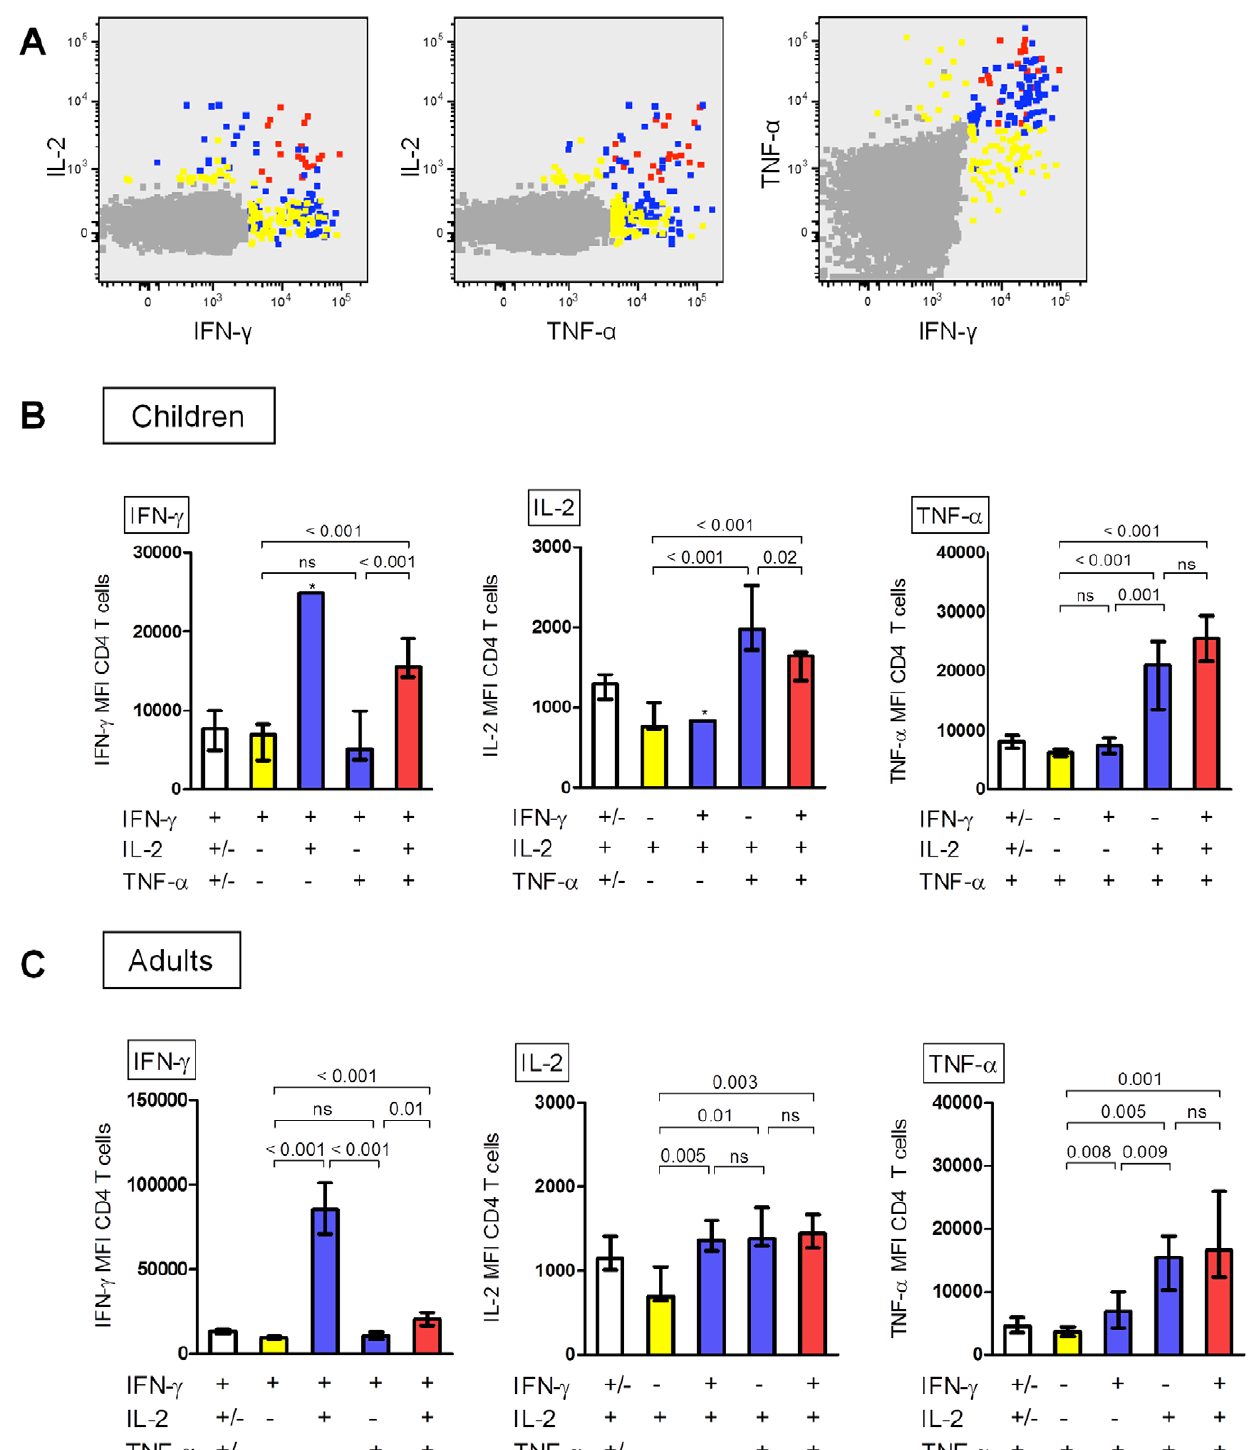
Figure 6. Fluorescence intensity of CD4 T cells following invitro stimulation with the antigen BCG. (A) Fluorescence intensity of single- (yellow), double-(blue), or triple-(red) cytokine-producing CD4 T cells in a representative child 10 weeks after BCG immunisation. Events are plotted on a logarithmic scale. Cells in the top right hand corner are those producing the greatest amount of both cytokines. (B, C) Median fluorescence intensity (MFI) for IFN- c -, IL-2- and TNF- a -producing CD4 T cell subpopulations following in vitro stimulation with the antigen BCG for (B) children (n=13) and (C) adults (n=13) 10 weeks after BCG immunisation. White bars show total cytokine-producing populations. Whiskers indicate IQR. Bars with * are based on one value only. Overall comparison was done using a Kruskal-Wallis test and comparisons of two populations were done using a Mann-Whitney test. The numbers above the horizontal bars represent the p-values for comparisons. ns = not significant (p . 0.05).